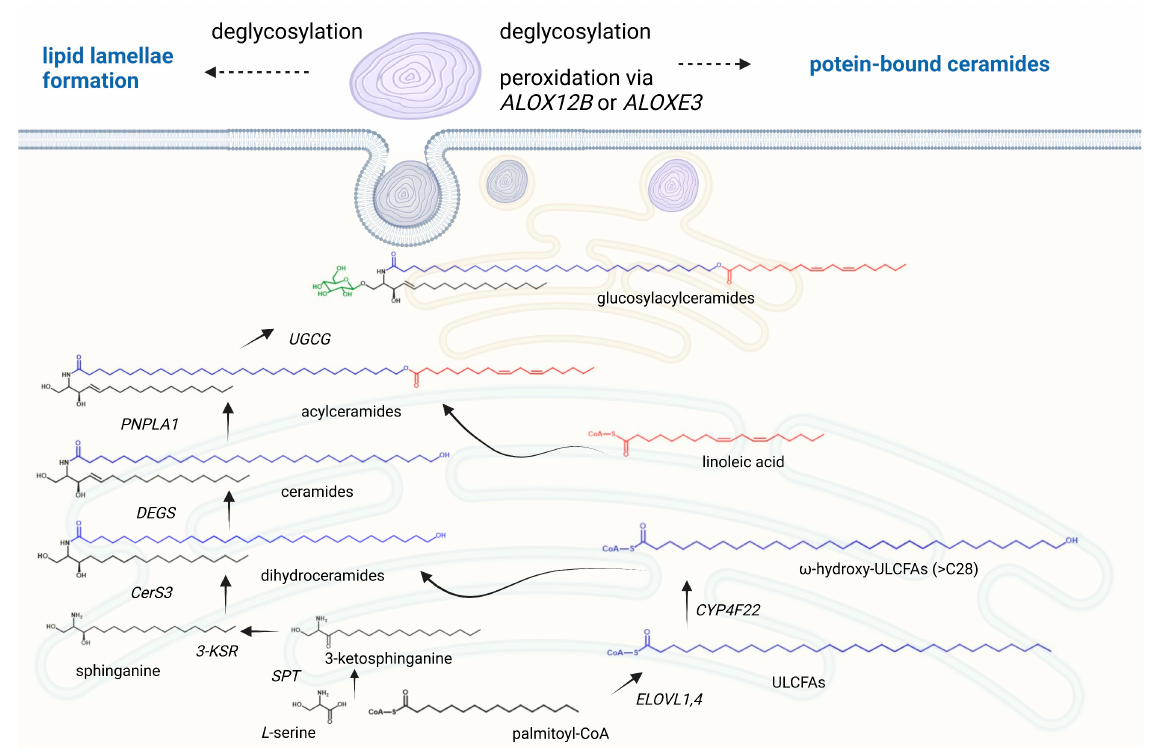
Figure 2. The formation of acylceramides in the human epidermis. Acylceramides are formed in the endoplasmic reticulum and secreted into the extracellular environment through the Golgi apparatus and assembling of lamellar bodies. The de novo pathway starts with the condensation of the serine and palmitoyl-CoA via the serine palmitoyl transferase (SPT). The resultant 3-ketosphinganine is then reduced by 3-ketosphinganine reductase (3-KSR) to sphinganine. The fatty acid elongases ELOVL1 and ELOVL4 yield ultralong-chain fatty acids of up to C26 and C28 carbon-chain-lengths, which are hydroxylated via CYP4F22 at the ω -position. These generated ω -hydroxylated ultralong-chain fatty acids (ULCFAs) are linked to the amino group of sphinganine by the ceramide synthase 3 (CerS3), leading to the formation of dihydroceramides. The introduction of a double bond between carbons C-4 and C-5, mediated by dihydroceramide desaturase, forms the central product of ceramide. The transacylase PNPLA1 (Patatin-Like Phospholipase Domain Containing 1) generates an ester linkage between the fatty acid taken from triglycerides and the ω -hydroxy group from ceramide to create the acylceramide. In the Golgi apparatus, acylceramides are glycosylated by the UDP-glucose ceramide glucosyltransferase UGCG, followed by an ABCA12-mediated transport into lamellar bodies. After secretion, glucosylacylceramides are reconverted back to their ceramide species to form organized lipid lamellae. For the generation of protein-bound ceramides, the fatty acid portions of acylceramides are oxidized via the lipoxygenases ALOX12B and ALOXE3, which enables a cross-link of the ω -hydroxyl group with cornified envelope proteins such as involucrin and envoplakin. Created with BioRender.com.